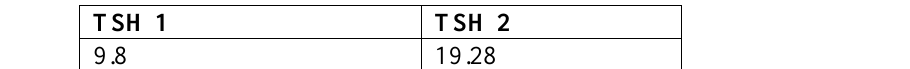
Table10: shows the TSH status after metformin in 15 patients with increase in the TSH after 2 months.